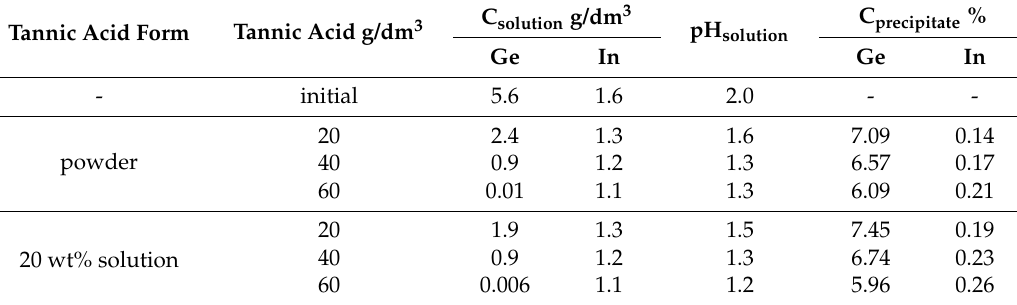
Table 4. Composition of the solution and precipitate after precipitation with tannic acid powder and